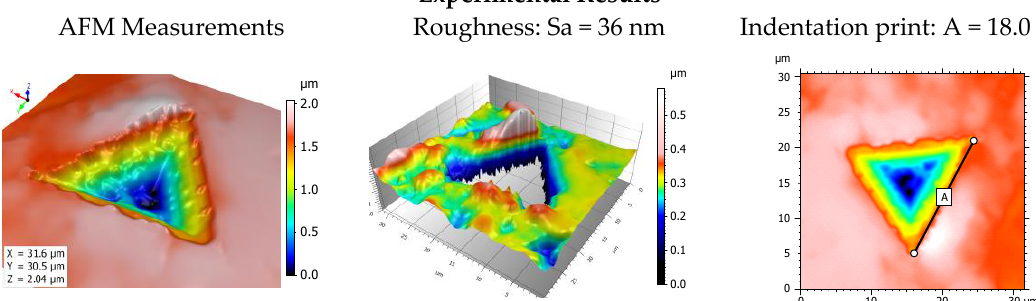
Figure 9. Nano-Indentation of TA6V samples ( left ), roughness extraction ( center ), indentation print measurements ( right ).